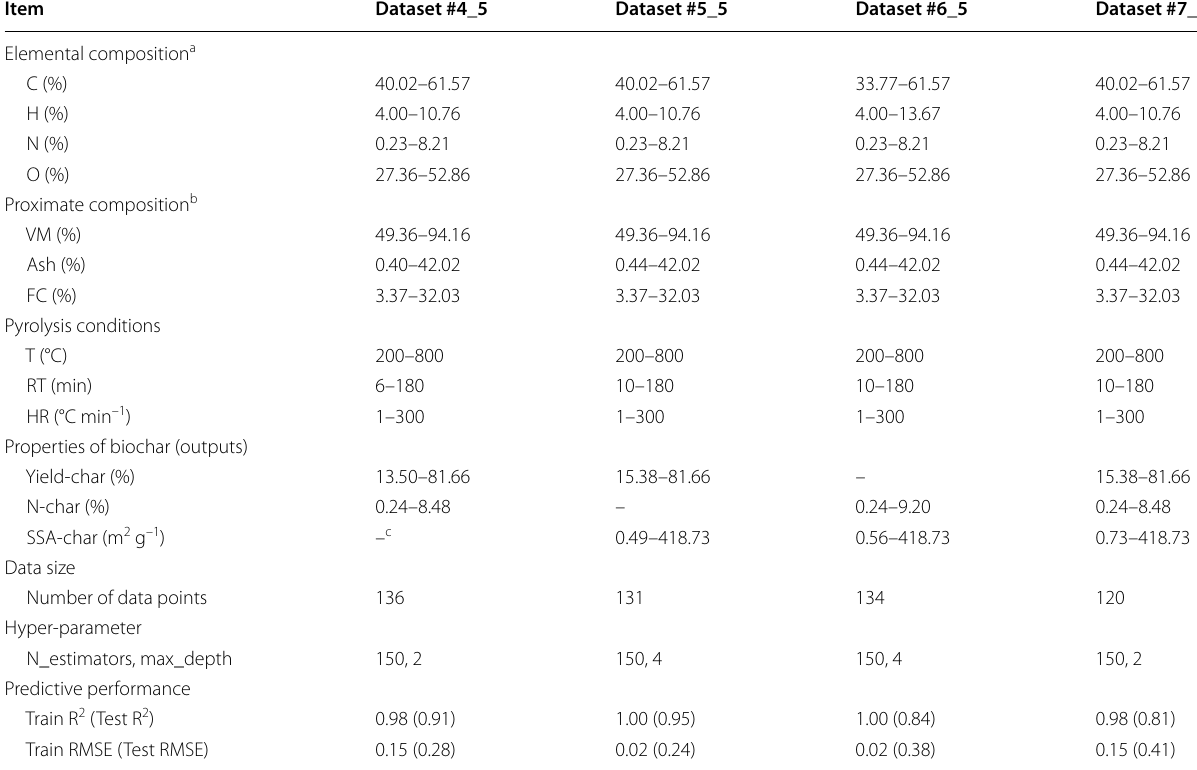
Table 4 The parameter scale of the elemental composition, the proximate composition and the pyrolysis conditions for